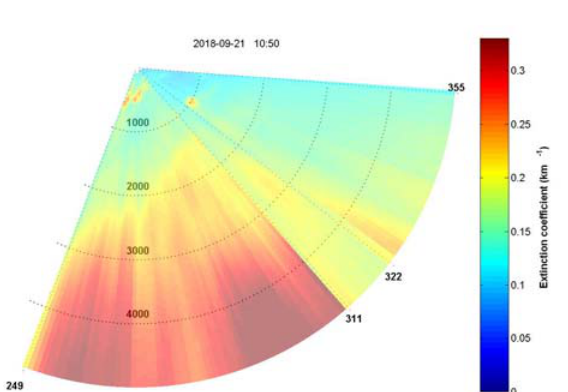
Fig. 3. Scanning map of the aerosol extinction coefficient measured at 10:50 on September 21 st , 2019. Region A: 249°-311°, elevation angle 5.5°; region B: 312°-322°, elevation angle 8.5°; region c: 323°-355°, elevation angle